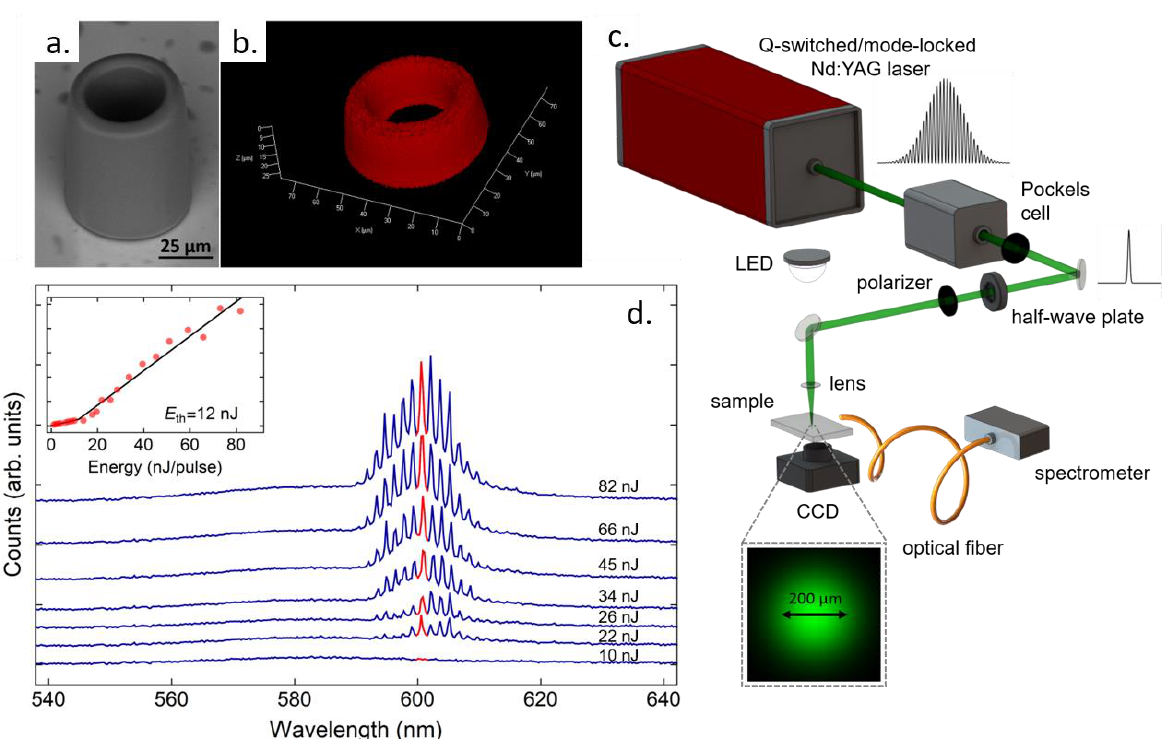
Figure 14. Rhodamine B-doped WGM polymeric microlaser fabricated by TPP. ( a ) Scanning electron, and ( b ) 3D recon- structed confocal fluorescence micrographs of the microlaser. ( c ) Setup used to excite the microlasers and collect their emission. ( d ) Emission spectra of a microlaser for the excitation energy levels indicated on the right hand side of the graph. To make the visualization easier, an offset was applied to the y-axis of each curve. The first curve represents the spectrum below lasing threshold. The inset shows a graph of the amplitude of the peak highlighted in red as a function of excitation energy. The graph is plotted on a linear scale. The threshold energy, which was obtained by fitting the experimental data with a bilinear curve (black line), is indicated in the graph. Adapted with permission [31]. Licensed under a Creative Commons Attribution 4.0 International license.